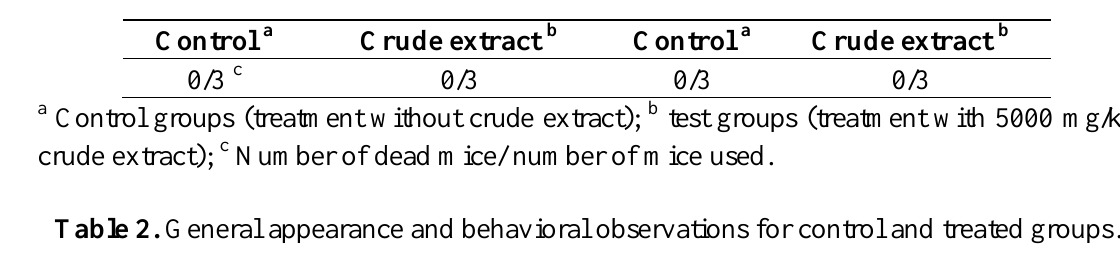
Table 1. Potential toxic effects of the crude extracts of C. fistula seeds in mice.